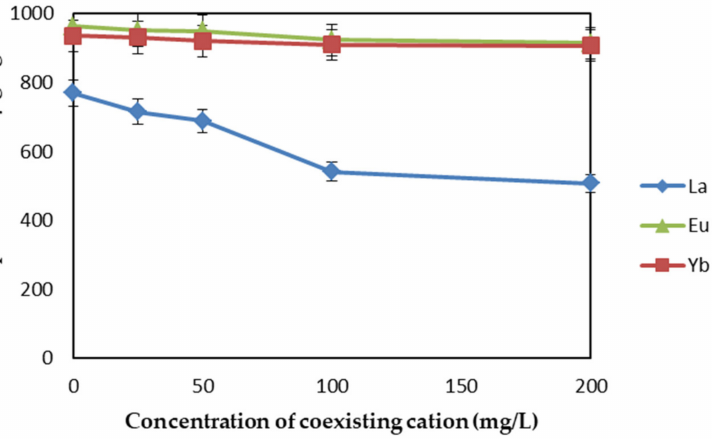
Figure 8. Effect of competitive ions (0, 25, 50, 100, and 200 ppm of Na + , K + , Ca 2+ , and Mg 2+ ) on REEs adsorption by